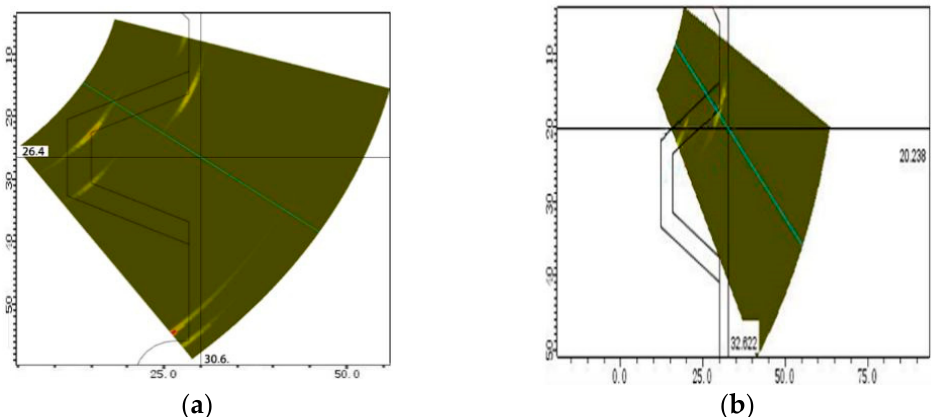
Figure 10. Echo analysis of the structure signal in the defect-free position of the test specimen. ( a ) Offset distance ( >20 mm ) ( b ) Offset distance ( 10–15 mm ).